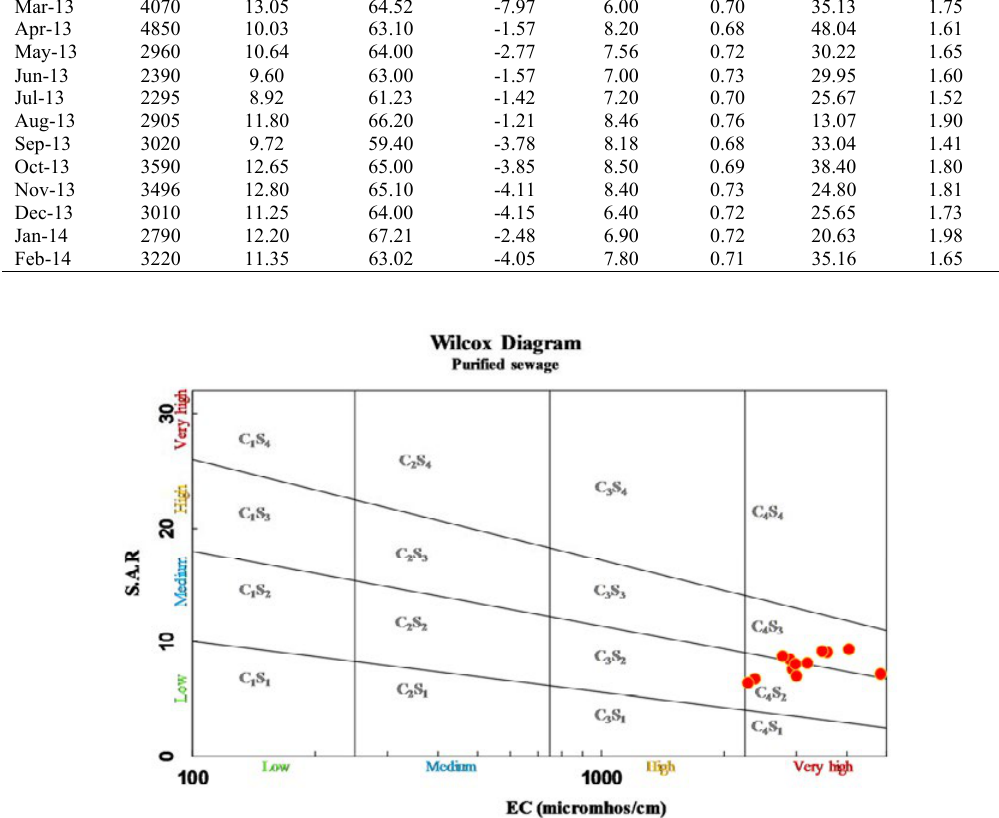
Fig. 5: Wilcox diagram of the samples collected from the TWW, showsing the medium to high sodium hazard and high and very high salinity hazards